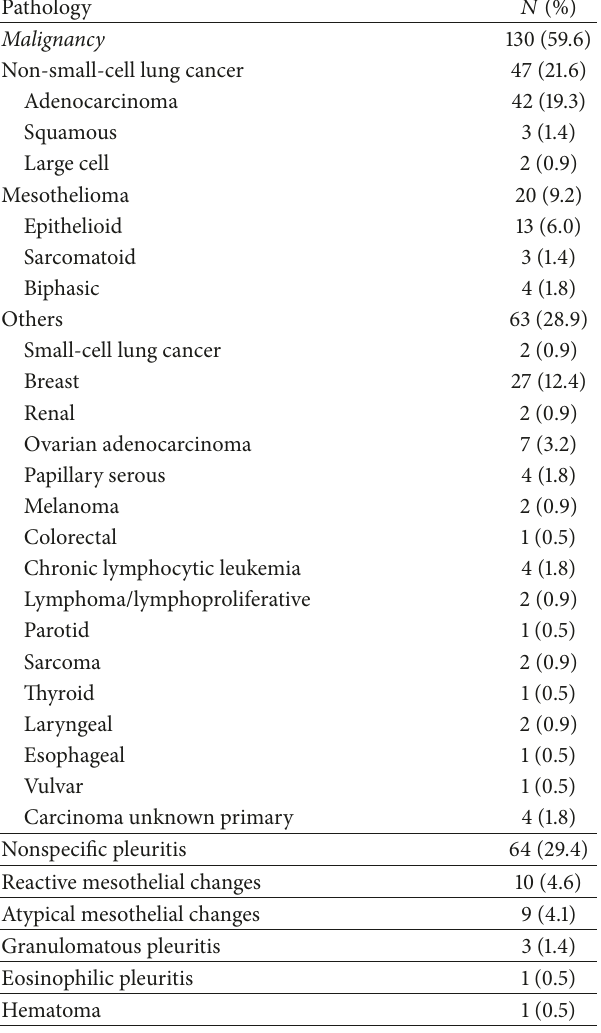
Table 3: Pathology